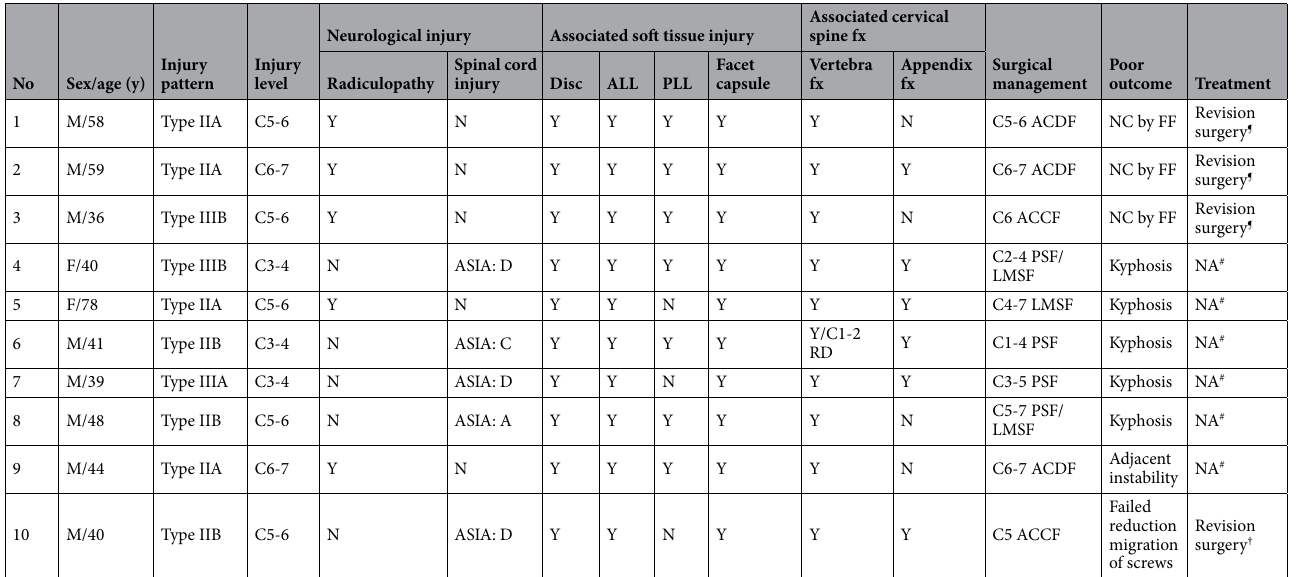
Table 6. The detailed data of poor outcome cases and management. ASIA, American Spinal Injury Association; RD, rotational dislocation; ACDF, anterior cervical discectomy and fusion; ACCF, anterior cervical corpectomy and fusion; PSF, pedicle screw fixation; LMSF, lateral mass screw fixation; NC, never root compression; FF, fracture fragment; NA, not available. # No revision surgery. ¶ Revision surgery by posterior ipsilateral facet resection, foramen enlargement, and pedicle and (or) lateral mass screw fixation. † Revision surgery by posterior facet release and reduction combined with extending the anterior fusion